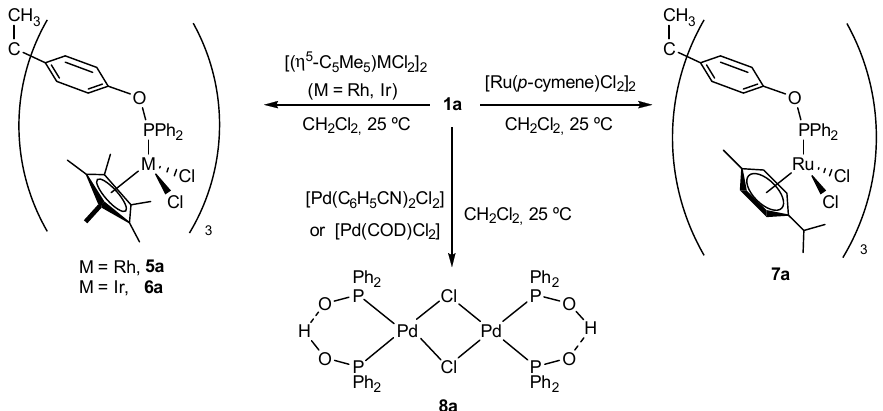
probability. Hydrogen atoms have been excluded for the sake of clarity. Selected bond distances